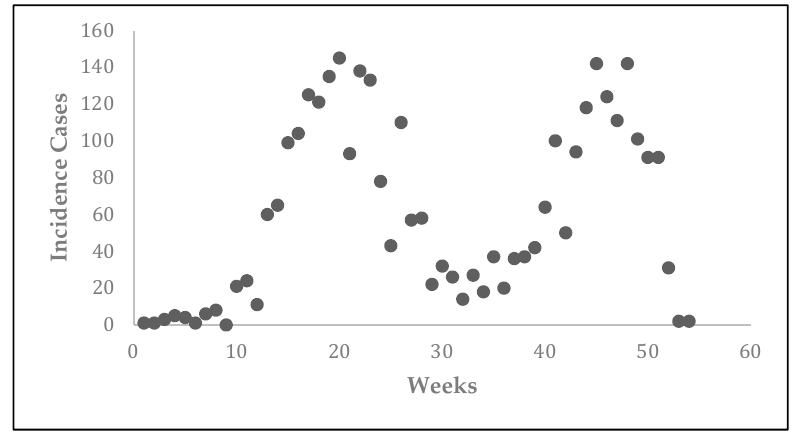
Figure 3. Reported number of new cases of CL from Tolima, Colombia during 2016.